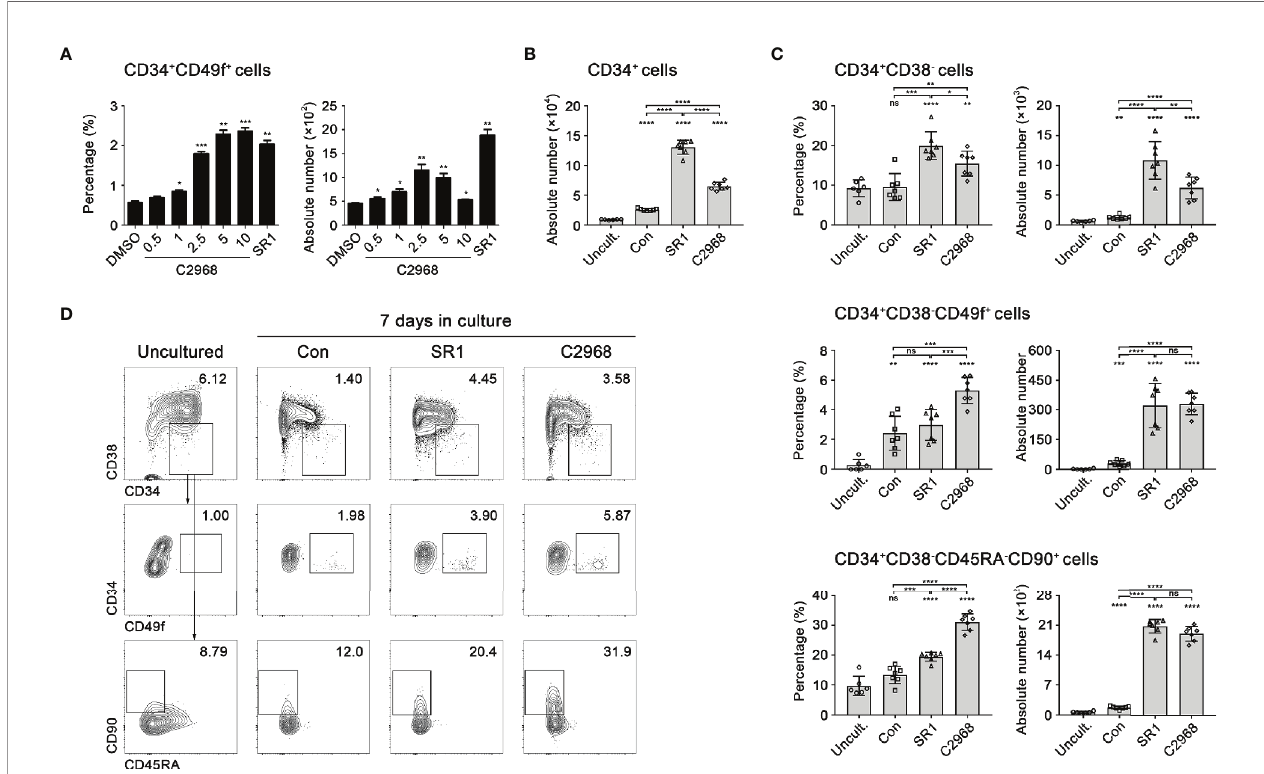
FIGURE 1 | Chrysin promoted in vitro expansion of primitive human hematopoietic stem and progenitor cells. (A) The percentages and absolute numbers of CD34 + CD49f + cells after 7 days in cultures supplemented with concentration gradient (0.5, 1, 2.5, 5, and 10 µM) of C2968 (n = 5). The concentration of SR1 was 1 µM. (B) Quanti fi cation of total input and output CD34 + cells in culture (n = 7; n = 6 for uncultured cells). UCB CD34 + cells (1 × 10 4 ) were seeded in the beginning of the culture. (C) The percentages and absolute numbers of CD34 + CD38 − , CD34 + CD38 − CD49f + , and CD34 + CD38 − CD45RA − CD90 + cells derived from uncultured CD34 + cells or after 7 days in cultures supplemented with Con [dimethyl sulfoxide (DMSO) 0.01%], SR1 (1 µM), and C2968 (2.5 µM) (n = 7; n = 6 for uncultured cells). All data represent the means ± SD. Compared with uncultured group unless speci fi ed, *p < 0.05, **p < 0.01, ***p < 0.001, ****p < 0.0001 and ns, no signi fi cance by two-tailed unpaired t-test. ○ , □ , D and ◊ represent a single data point in Uncultured (Uncult.), Con, SR1 and C2968 groups respectively. (D) Representative FACS pro fi les of CD34 + CD38 − , CD34 + CD38 − CD49f + , and CD34 + CD38 − CD45RA − CD90 + populations derived from total live cells in uncultured and cultured CD34 +